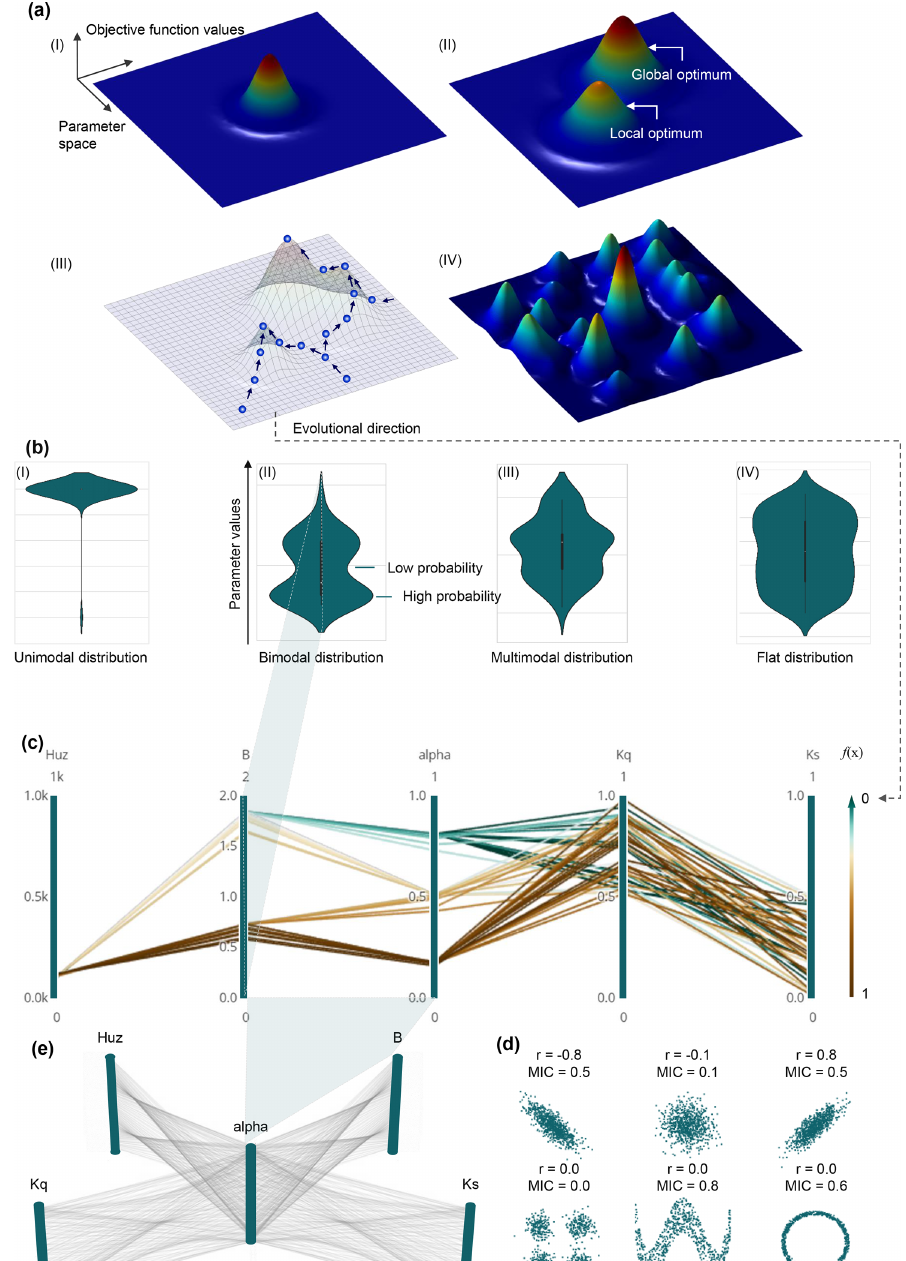
Figure 5. (a) Intuitive sketches of three-dimensional fitness landscapes with possible properties. The vertical axis denotes the objective function values and the horizontal axes denote the parameter space. The arrows represent various paths that the population could follow while evolving on the fitness landscape. (b) Evolutionary processes in individual parameter spaces using violin plots. The vertical axis of the violin plot denotes parameter values; the horizontal axis denotes the probability values. (c) Evolutionary processes in multiparameter space using parallel coordinates. These parallel axes represent individual parameters. The polylines describe the parameter set. The evolutionary process evolves toward minimizing the objective function values f (x) . Hence, the color changes in parallel coordinates could represent the evolutional direction of the fitness landscapes. (d) Spotting the envelope of lines between axes adjacent to the scatter plot (Zhang et al., 2014). (e) Multi-relational 3D parallel coordinate plots (Heinrich and Weiskopf,